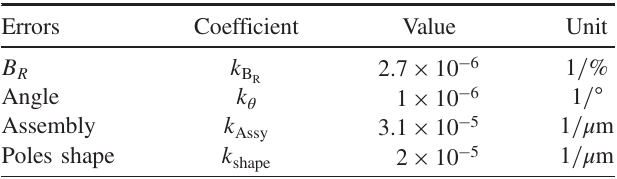
TABLE V. Harmonic sensitivity coefficients (PM blocks trans- lated vertically), assuming 6 PM blocks in each